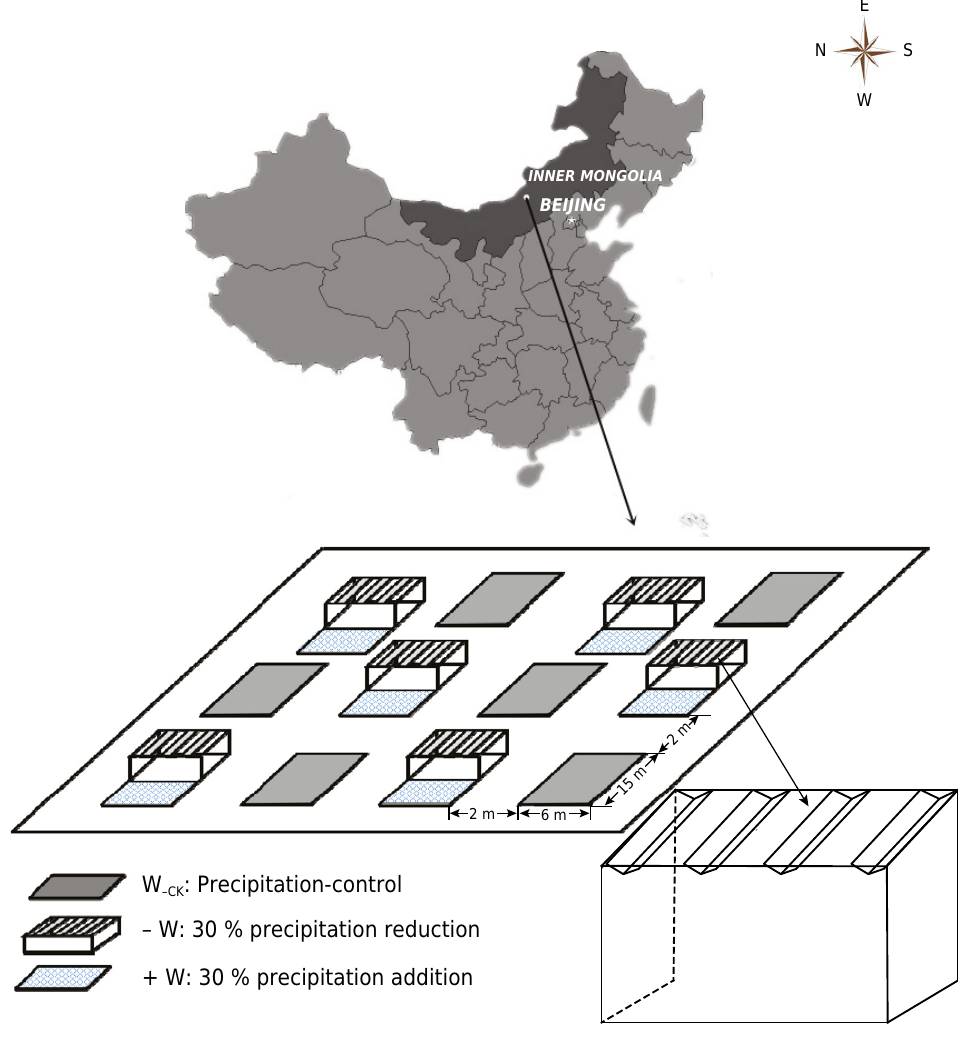
Figure 1. Study site and 3-dimensional schematic diagram of experimental